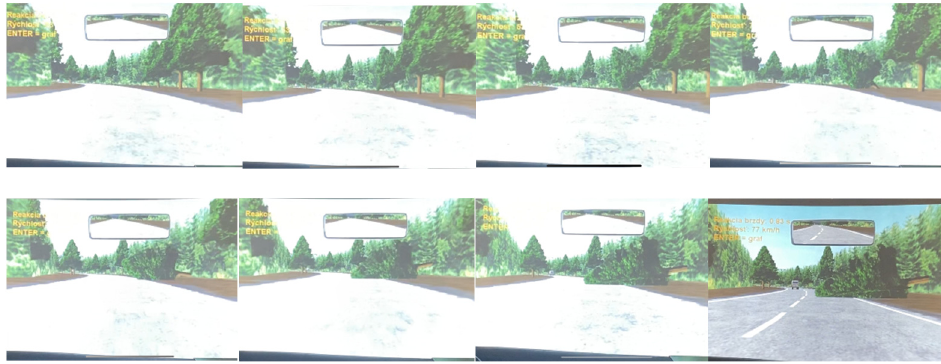
Figure 3. Simulator with the appearance of a falling tree on the screen. Source: own collaboration. On the other side, a different obstacle like a wild boar could appear at the right side of the screen but a similar situation could also happen at the left side side of the screen, where, e.g., a wild boar could be crossing the road from the left to the right, as is shown in Figure 4.